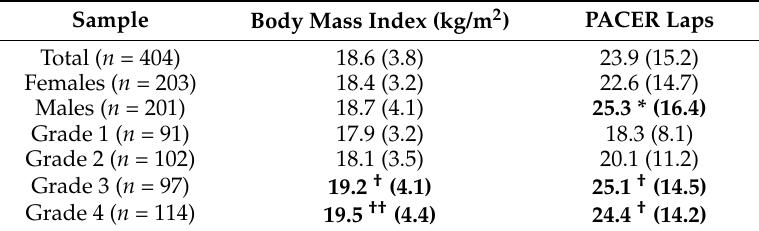
Table 1. Means and (standard deviations) at time point 1 for body mass index (BMI) and PACER laps.